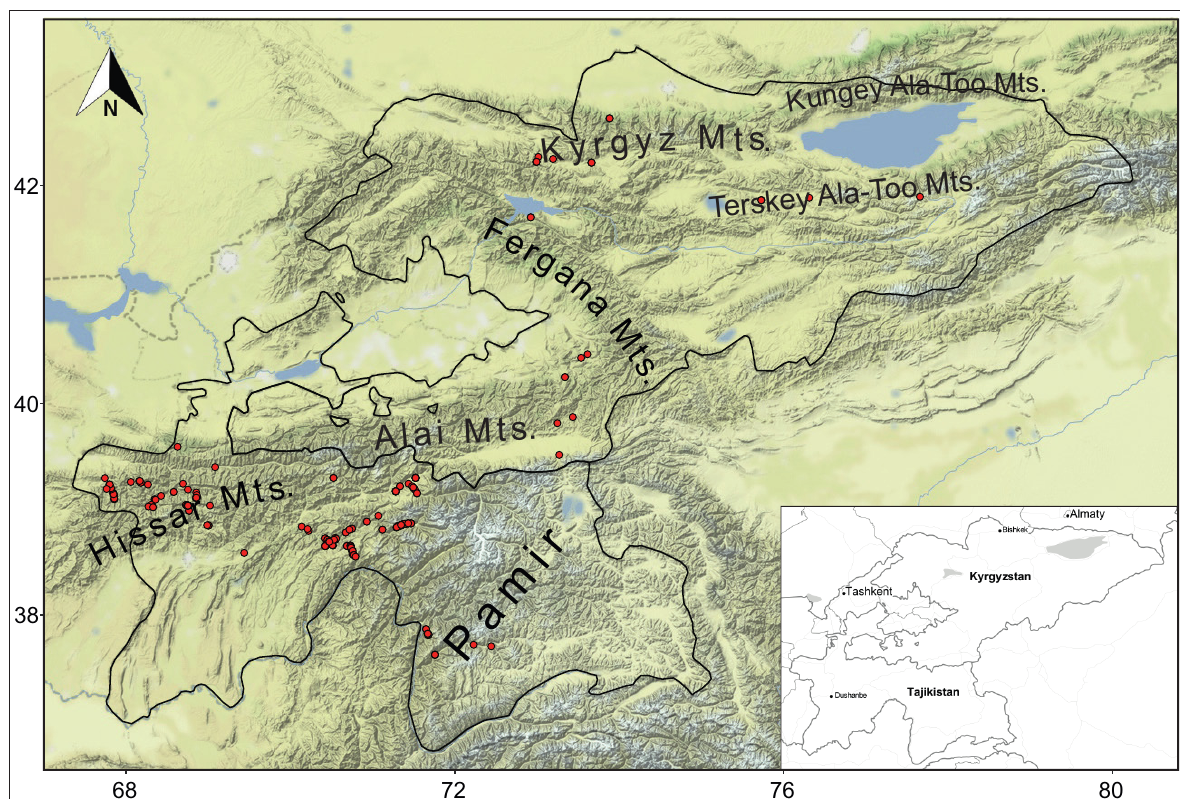
Figure 1. Study area and distribution of the vegetation plots ( n =